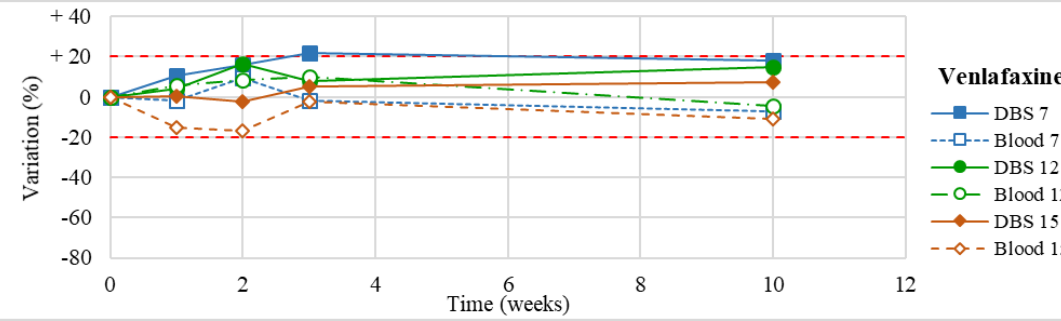
Figure 6. Long-term stability of venlafaxine ( n = 3) in DBSs stored at room temperature and in blood stored at −20 °C (T0–T4). Molecules 2019 , 24 , x FOR PEER REVIEW